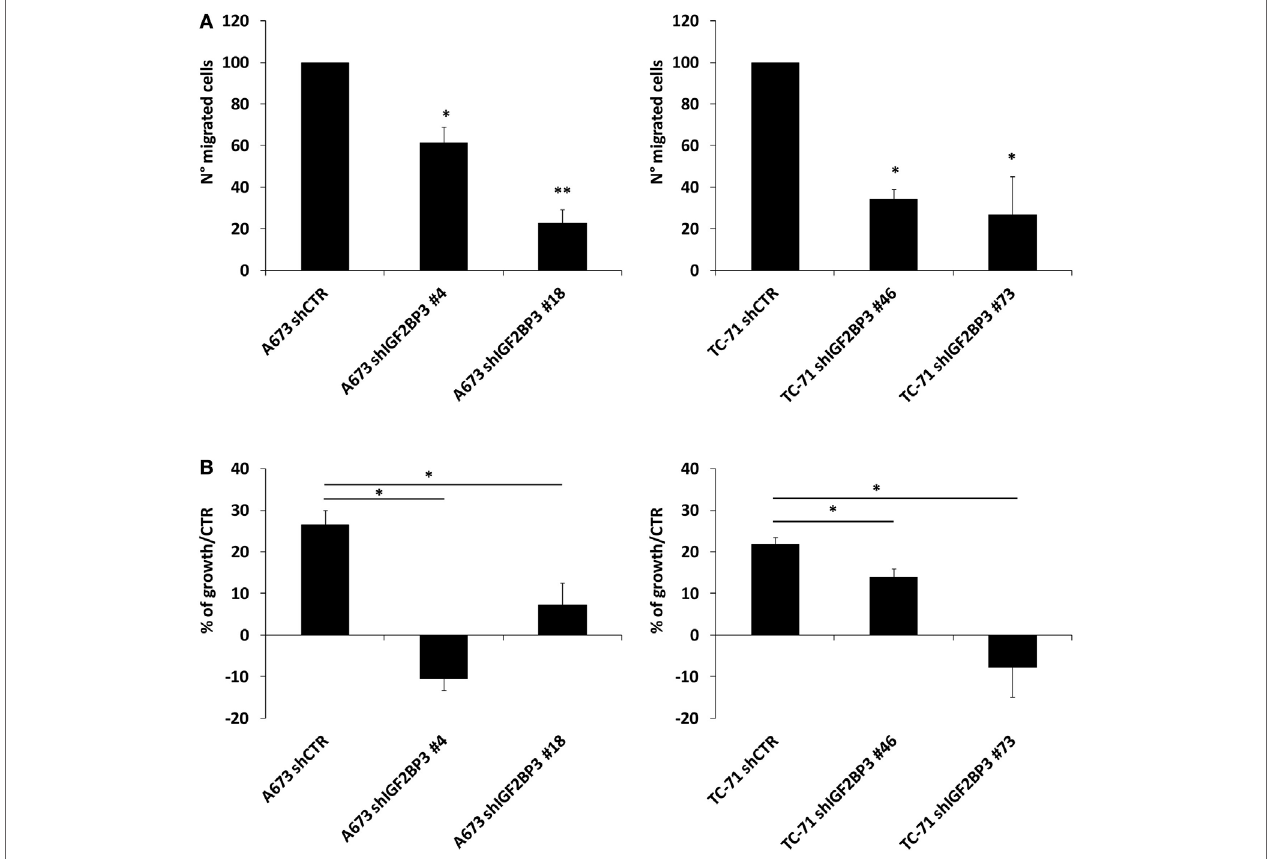
FigUre 3 | Evaluation of the oncogenic potential of insulin-like growth factor 2 mRNA-binding protein 3 (IGF2BP3)/IGF1R in Ewing sarcoma (ES) cell lines. (a) Migration of IGF2BP3-depleted or empty vector-transfected (shCTR) A673 or TC-71 ES cells in response to IGF1 (50 ng/ml) stimulation. Columns represent the mean values of two independent experiments, in which samples were run in triplicate, and the bars represent the SE. (B) Growth capacity of IGF2BP3-depleted or empty vector-transfected (shCTR) A673 or TC-71 ES cells after 24 h of IGF1 (50 ng/ml) stimulation. Trypan blue staining was used for cell counting. Columns represent the mean values of two independent experiments, in which samples were run in duplicates, and the bars represent the SE. (a,B) * p < 0.05, ** p < 0.01, one-way